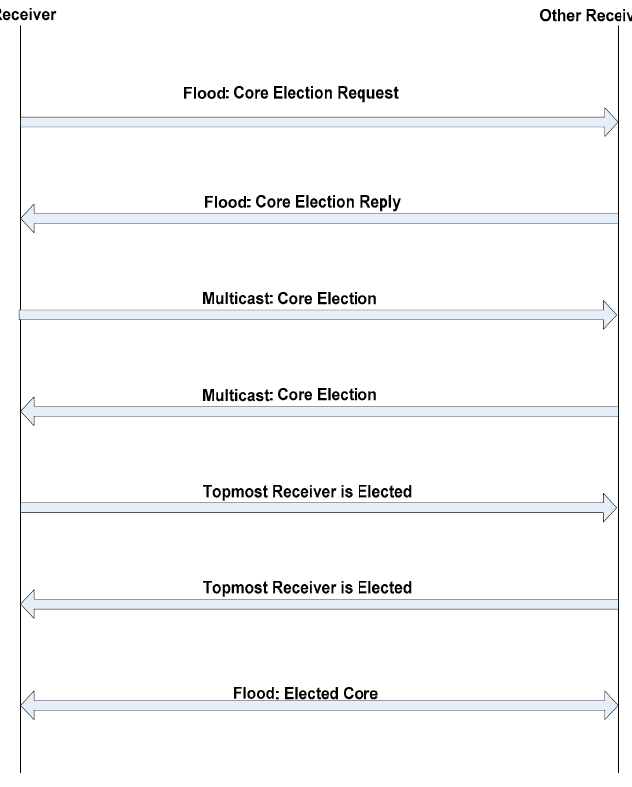
Figure 2. Core Election Process.